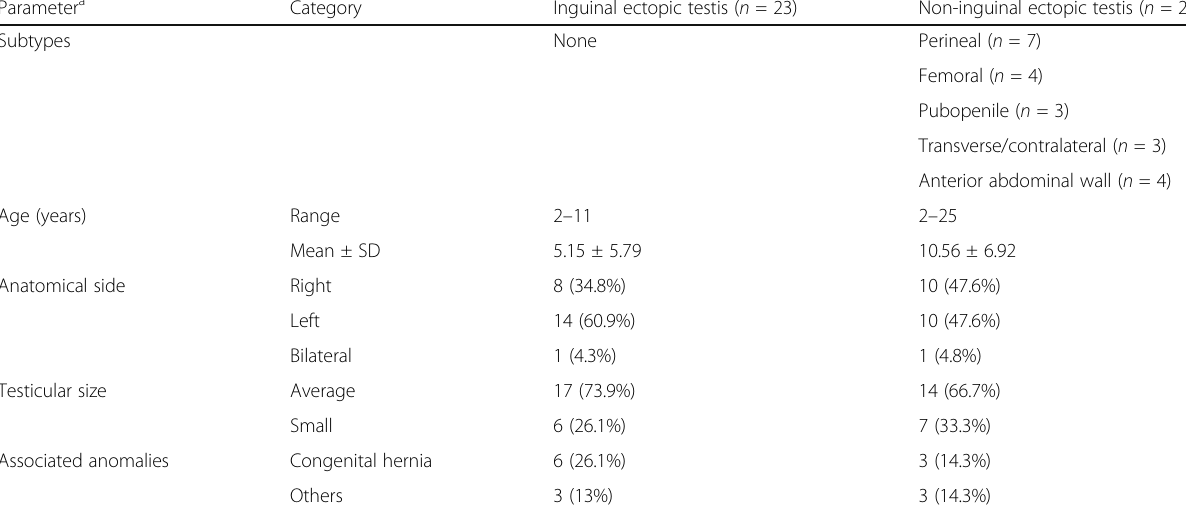
Table 1 Collective values and percentages of the common characteristics of the cases in both groups of testicular ectopia Parameter